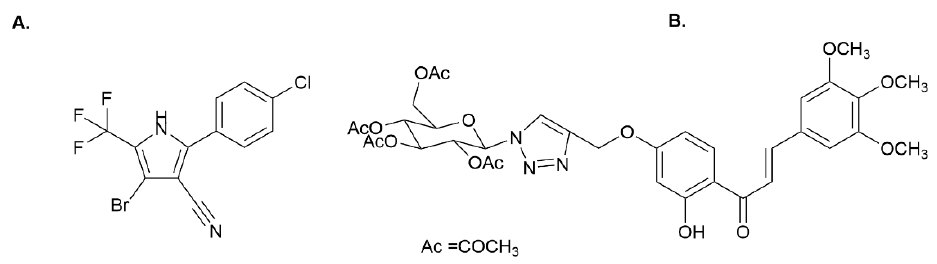
Figure 1. ( A ) Econea ® (tralopyril); ( B ) triazolyl glycosylated chalcone (compound 1